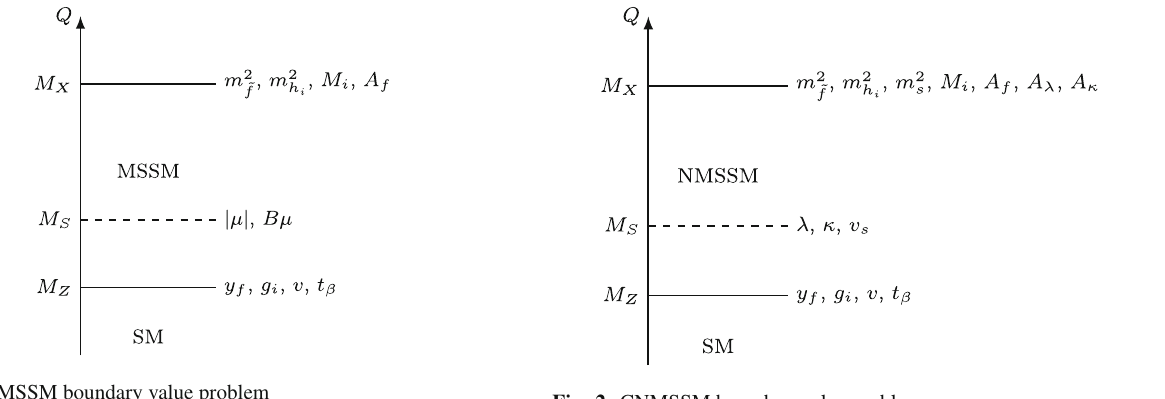
Fig. 2 CNMSSM boundary value